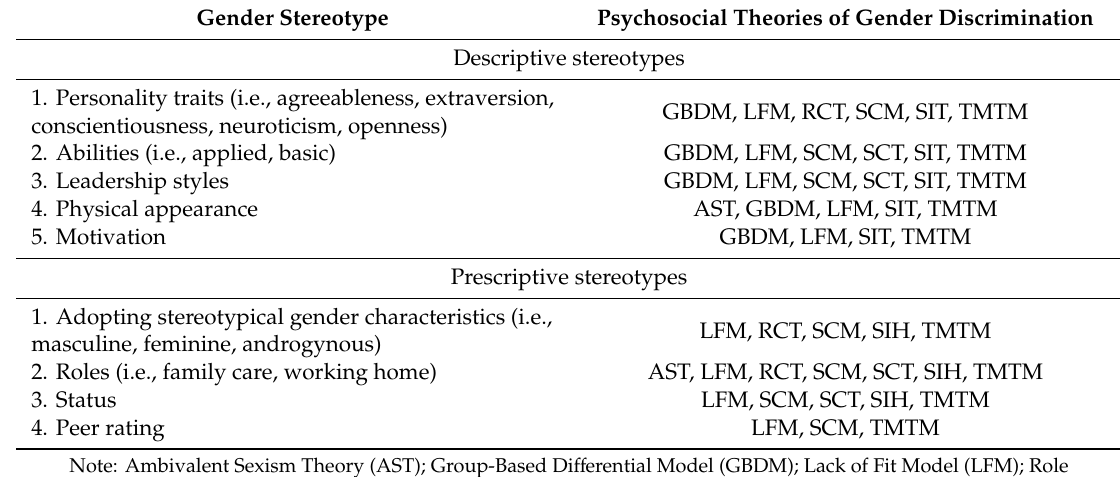
Table 7. Taxonomy of gender stereotypes and psychosocial theories of gender